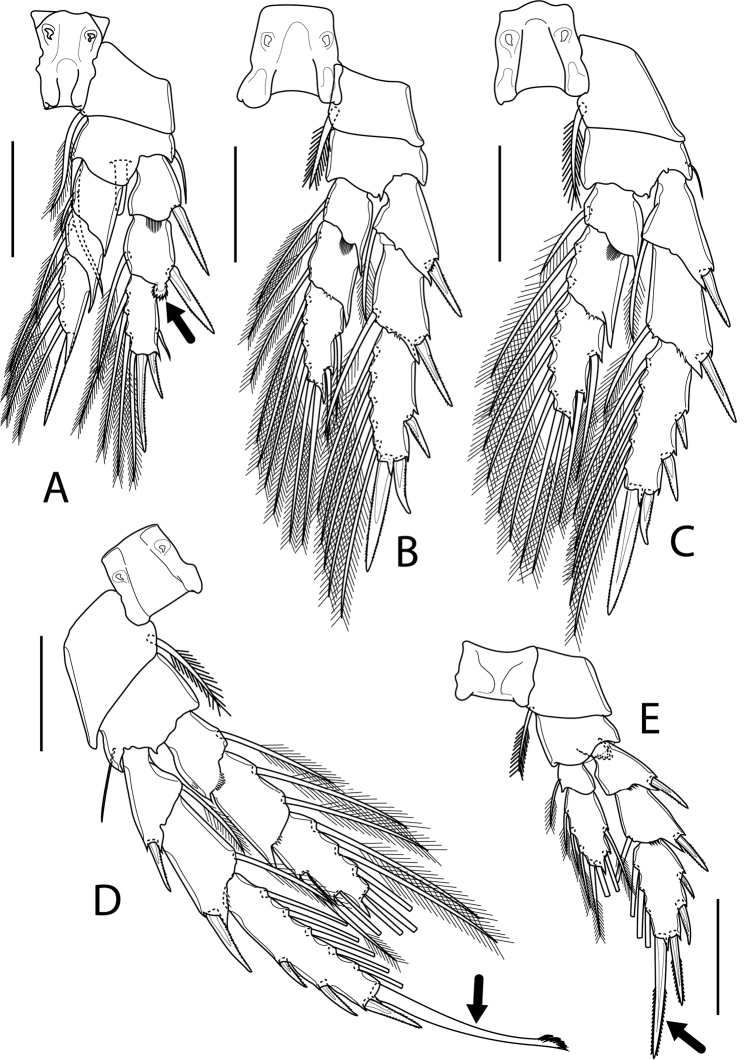
Boholina
laorsriae sp. nov. female: AP1BP2CP3DP4EP5. Scale bars: 50 μm.